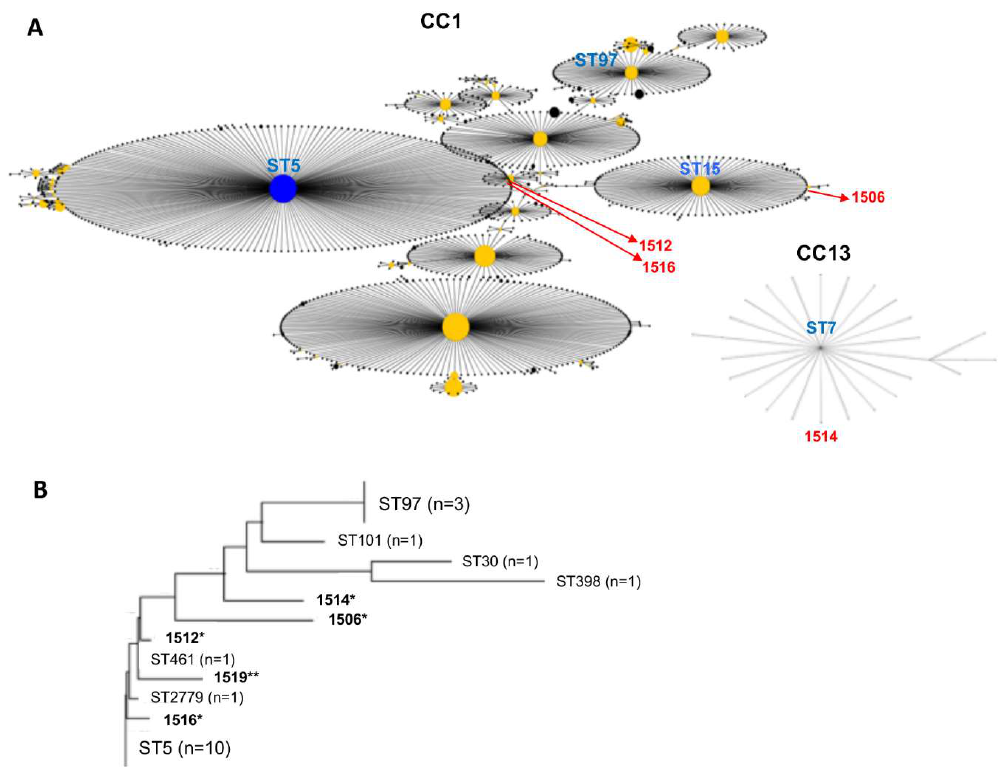
Figure 1. Clonal complex eBURST group analysis and the genetic relationship of the 23 S. aureus isolates. ( A ) The eBURST group was obtained for the four strains 1506, 1512, 1514, and 1516, based on six identical alleles (except for yqiL , four new sequences). The size of the circles shows the number of isolates for each ST (node), and the central node indicates the most prevalent ST in the CC group. Blue or yellow nodes indicate ST group founder or ST subgroup founder, respectively. The black line indicates one different allele between two ST groups. ( B ) Phylogeny shows the genetic relationship of strain 1519. * Indicates the strains also analyzed by eBURST and ** indicates the strain from which CC was inferred by phylogenetic analysis. A number between parentheses corresponds to the number of